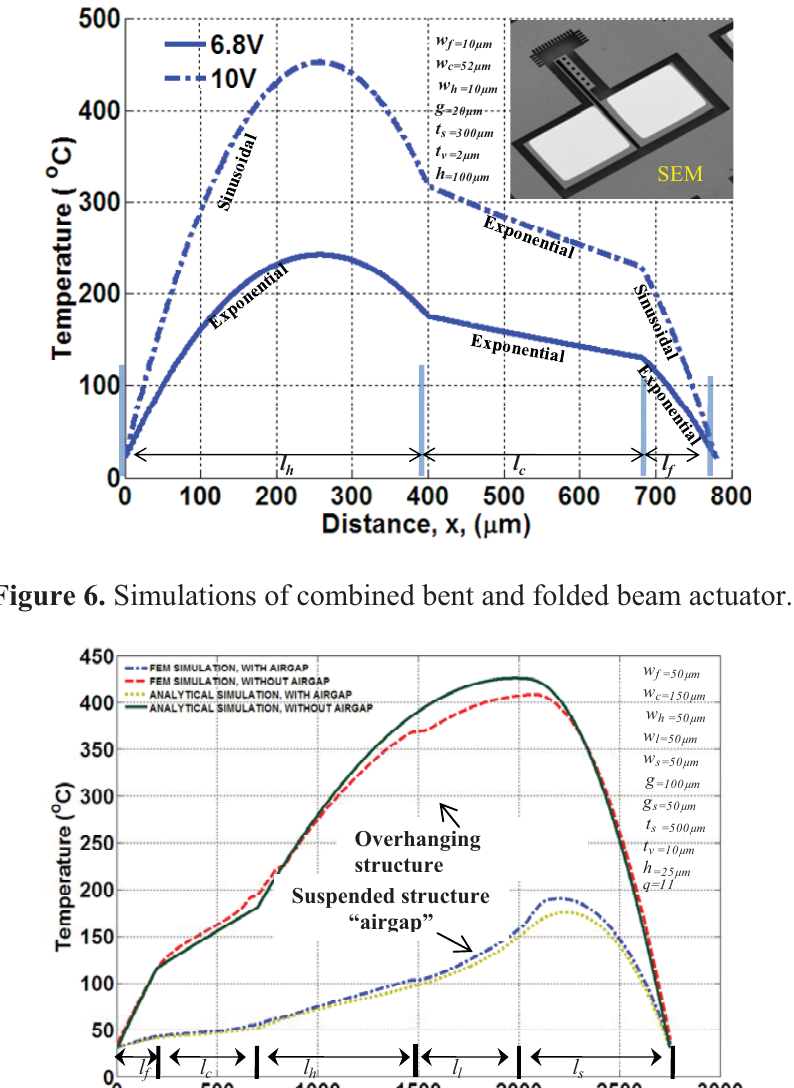
Figure 5. Simulations of the temperature profile in folded beam actuator.